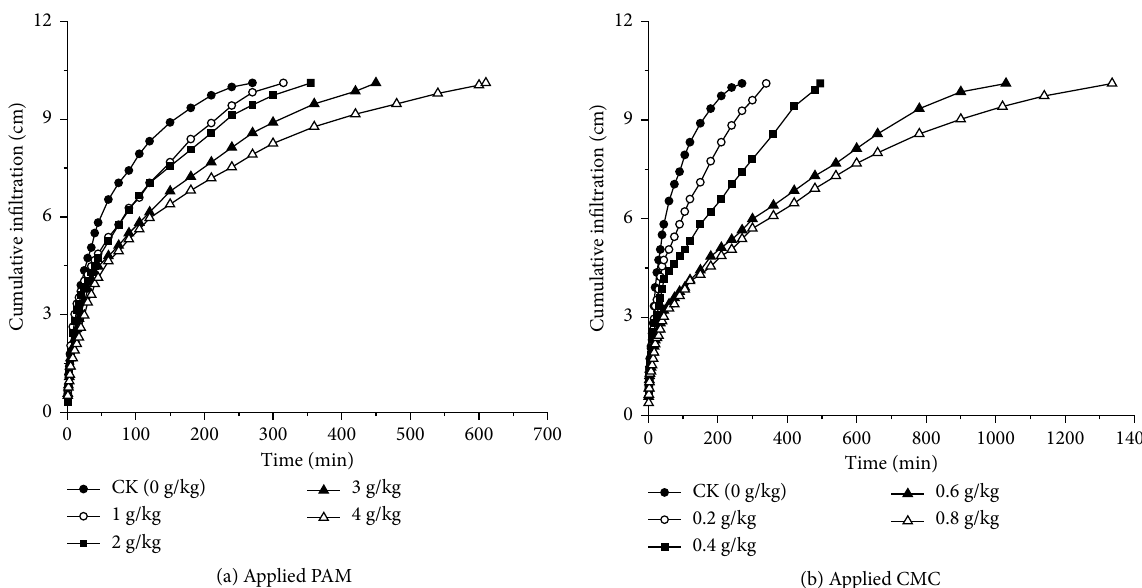
Figure 1: Effects of different application rates for (a) PAM and (b) CMC on cumulative infiltration in sandy loam